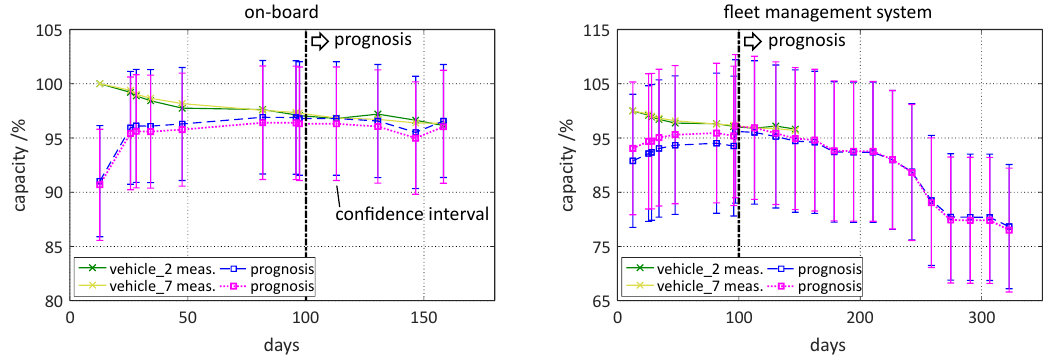
Figure 13. RVM prognosis results from the on-board approach on the left graph and from the fleet management system, respectively, for a longer time period on the